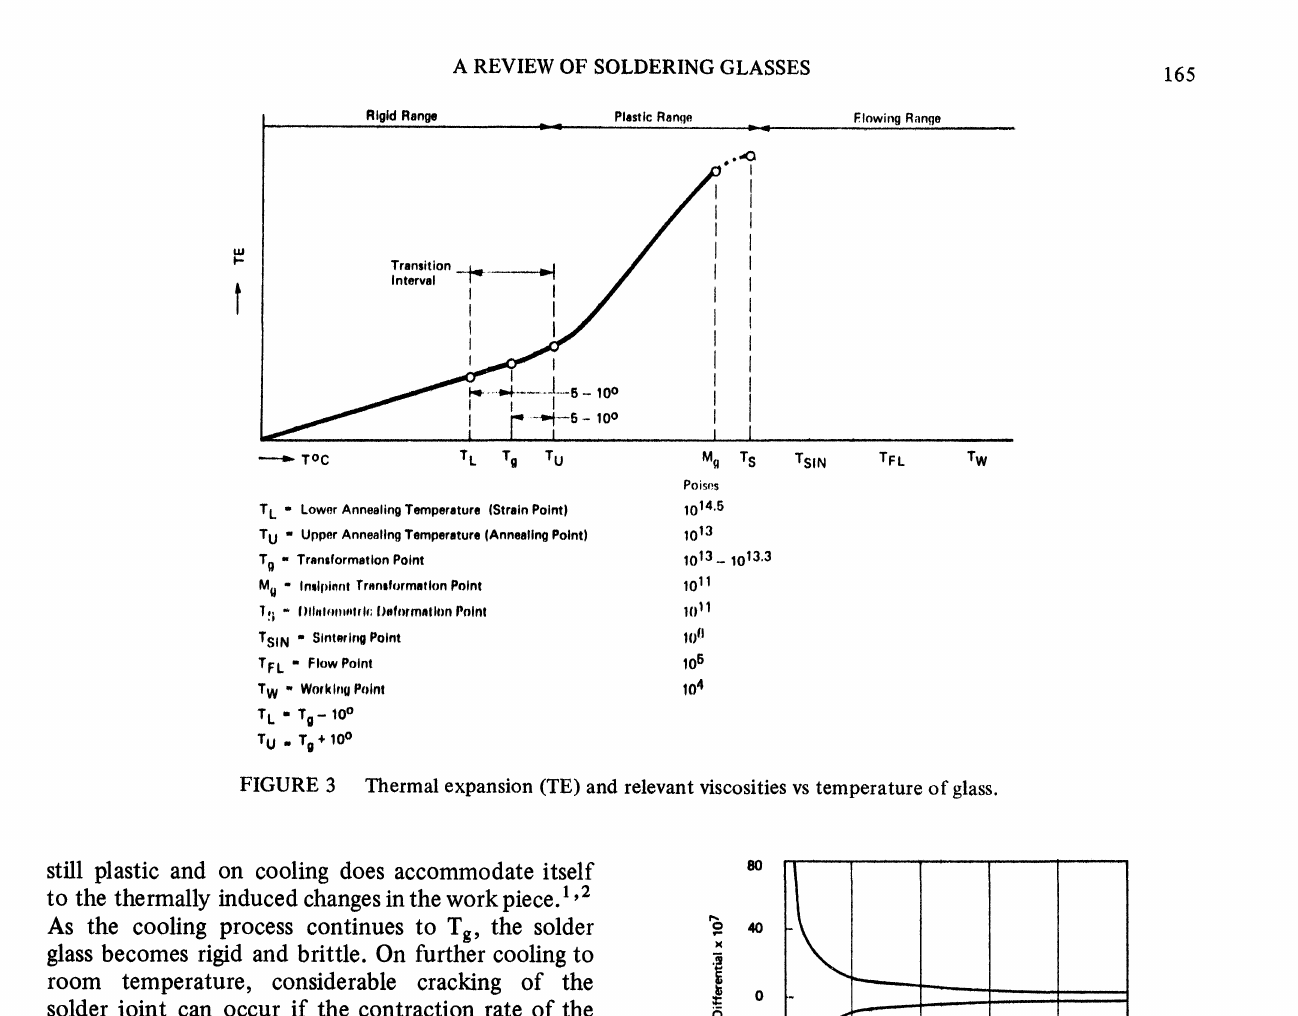
Permissible CTE mismatch vs. setting tempera- ture for solder